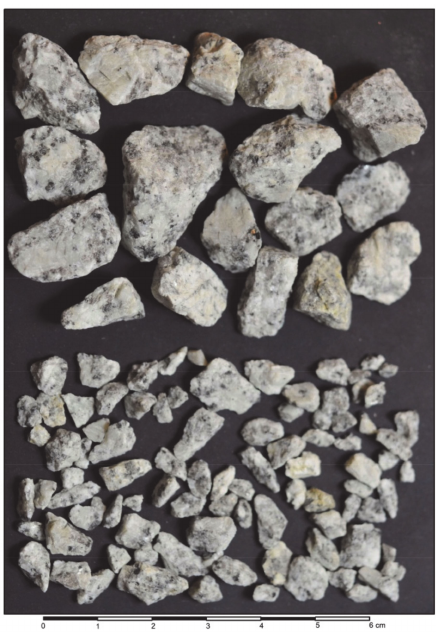
Figure 2. Granite fragments of coarse aggregates: medium and fine gravel.